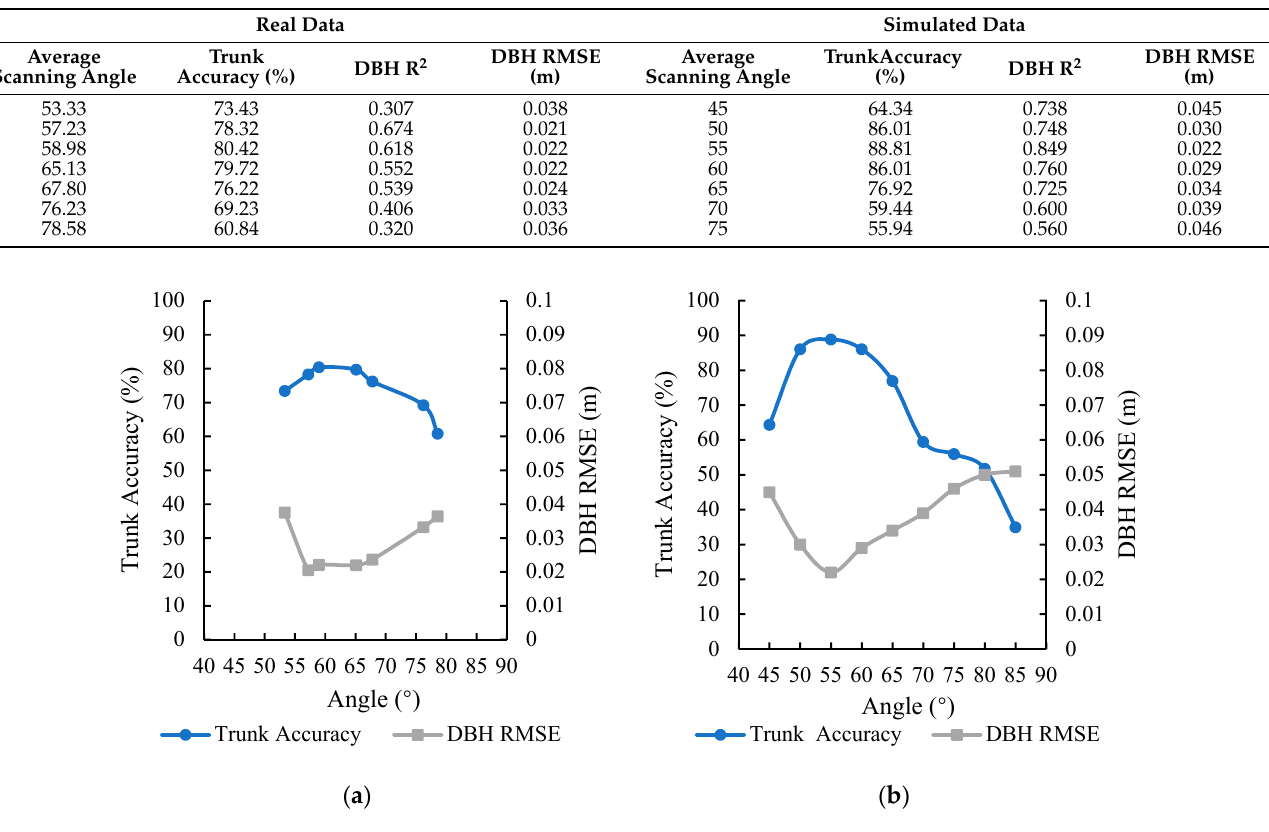
Figure 10. Variation curves of trunk point and DBH extraction accuracies for different scanning angles in quadruple-routes mode. ( a ) Real data; ( b ) simulated data.